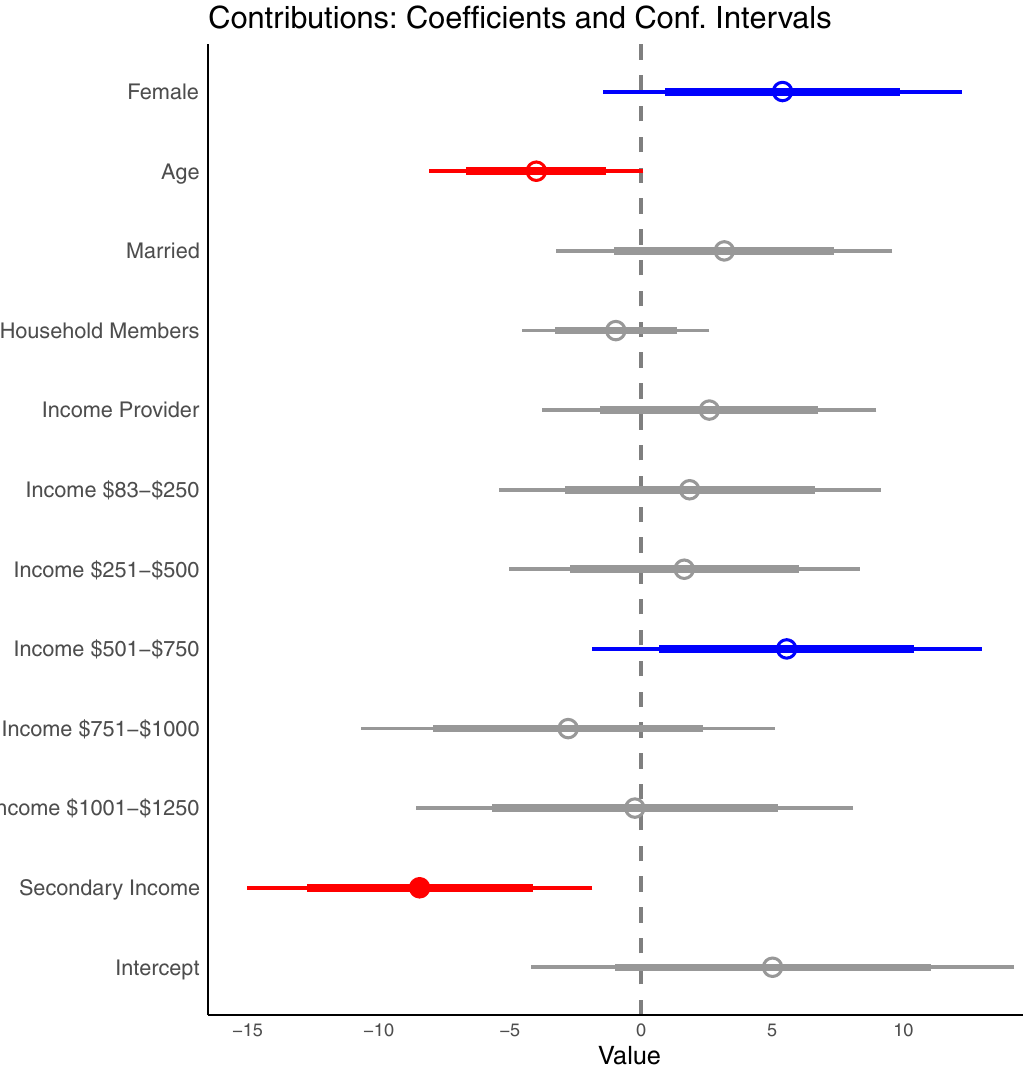
Figure 1. Coefficient plot of how contributions are related to gender, age, marital status, number of household members, whether a subject was the income provider, the levels of monthly income (in USD), and whether the subject had a secondary non-fishing income. Thick lines represent 80% confidence interval, while thin lines are 95% confidence